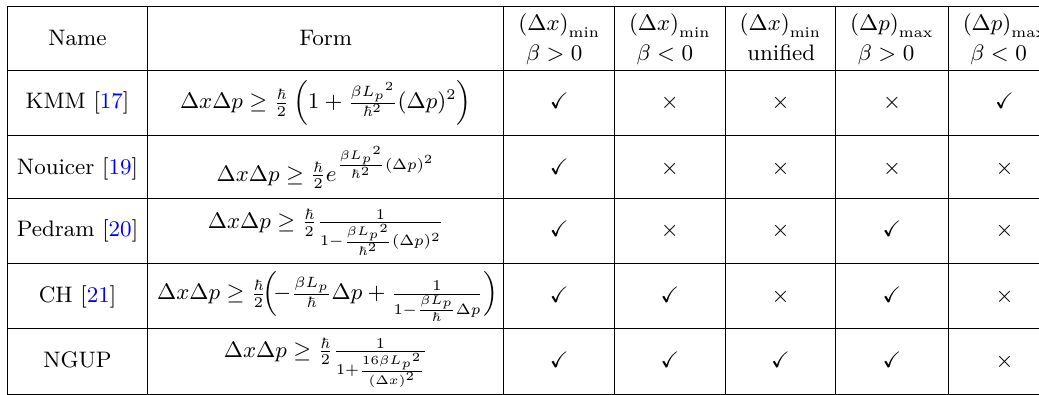
Table 1 . Comparisons of various generalized uncertainty principles. “ (∆ x ) the minimum lengths for β > 0 and β < 0 are unified. The tick stands for the state of including and the cross stands for the state of